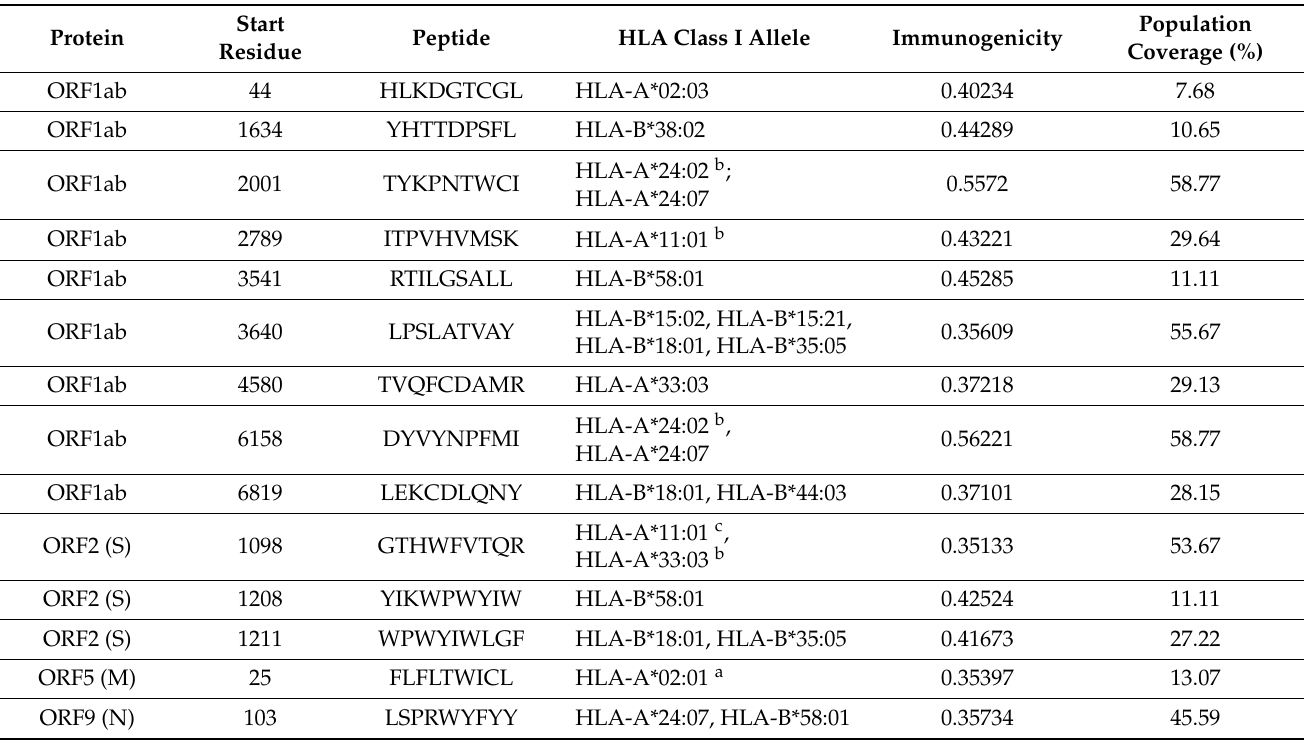
Table 2. Highly immunogenic (>0.35) 9-mer CTL epitopes identified from five different